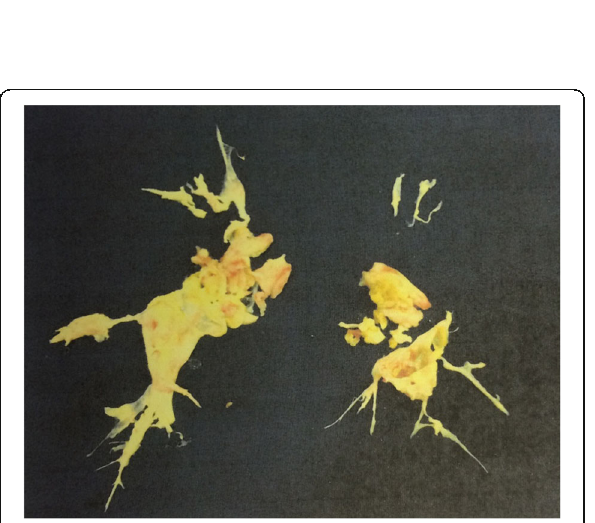
Fig. 3 Resected thromboembolism of both pulmonary